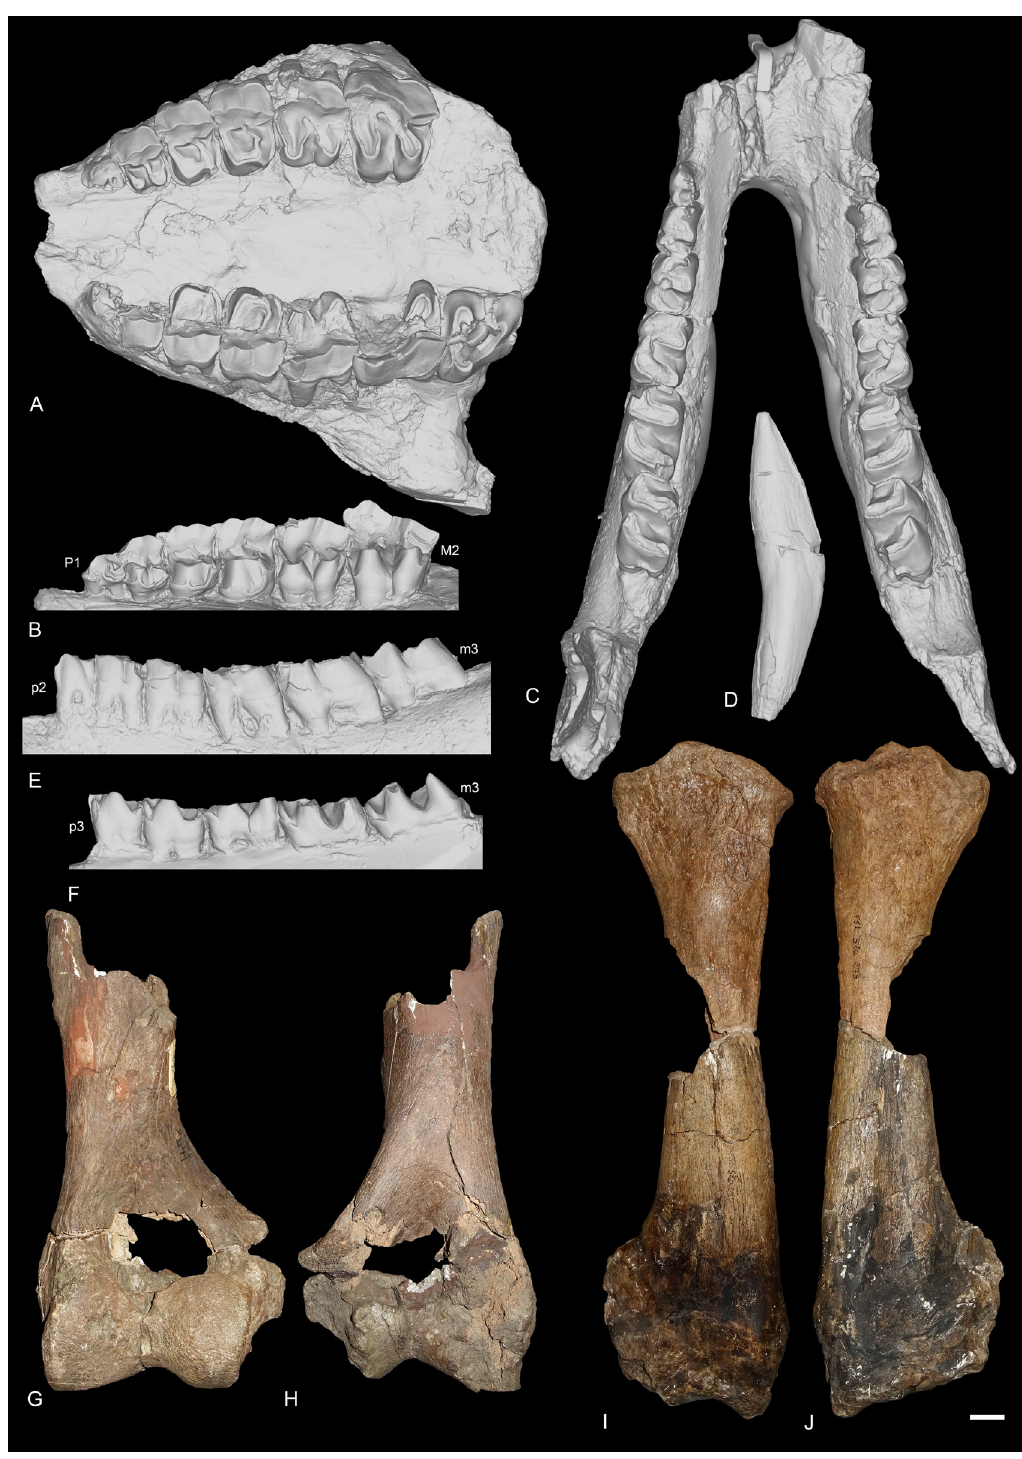
Fig. 17. Ronzotherium romani Kretzoi, 1940 from St-Henri/St-André/Les-Milles, near Marseille (late Oligocene, France). – A–B . Maxilla FSL-8547. A . Occlusal view. B . With left P1–M2 in lingual view. – C, E–F . Mandible FSL-8547 from the same individual. C . Occlusal view. E . With left p2–m3 in labial view. F . Right p3–m3 in lingual view. – D . Left i2 NMB-Mar-862, lingual view. – G–H . Left humerus FSL-9523. G . Anterior view. H . Posterior view. – I–J . Right radius FSL-520279+520280. I . Anterior view. J . Posterior view. Scale bar: 2